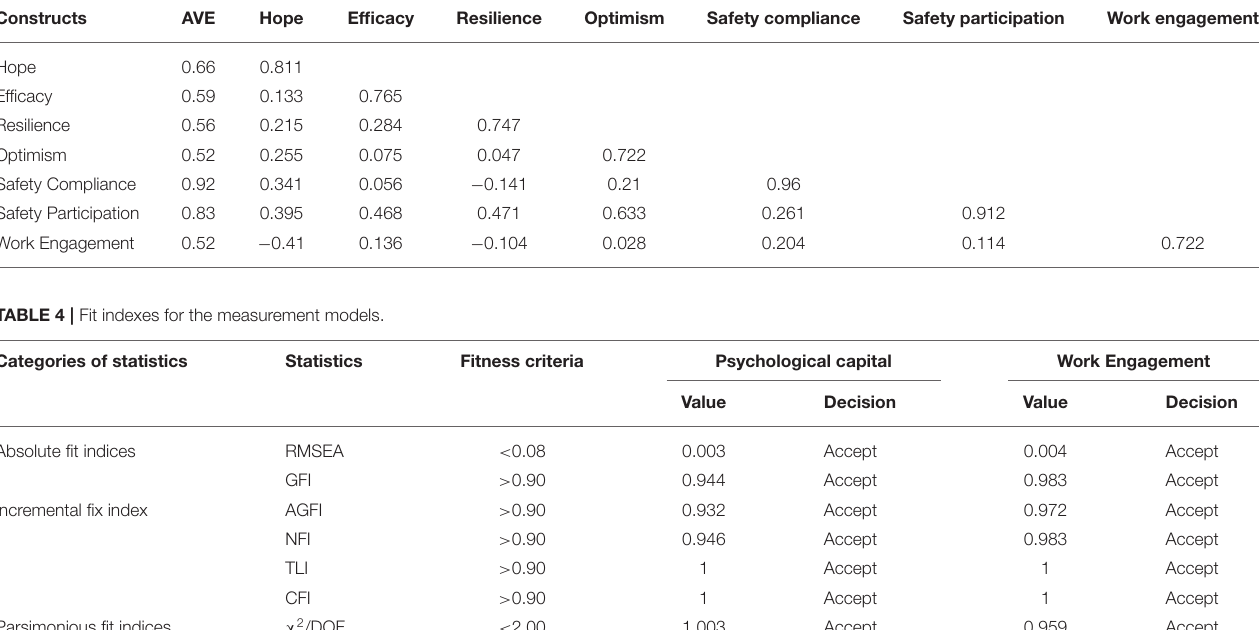
TABLE 3 | Discriminant validity results. Constructs